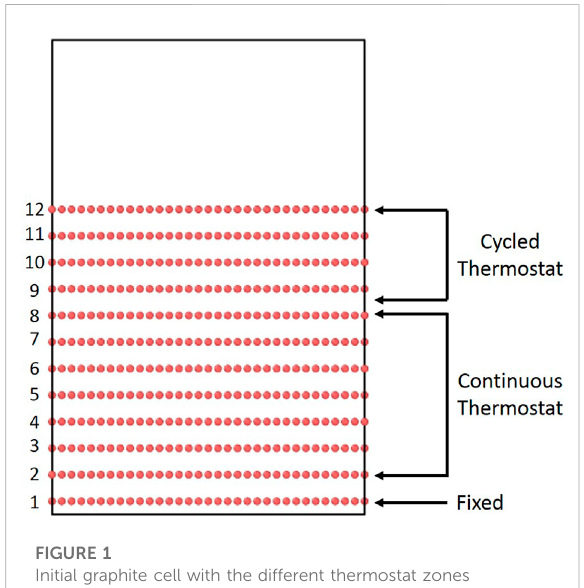
FIGURE 1 Initial graphite cell with the different thermostat zones